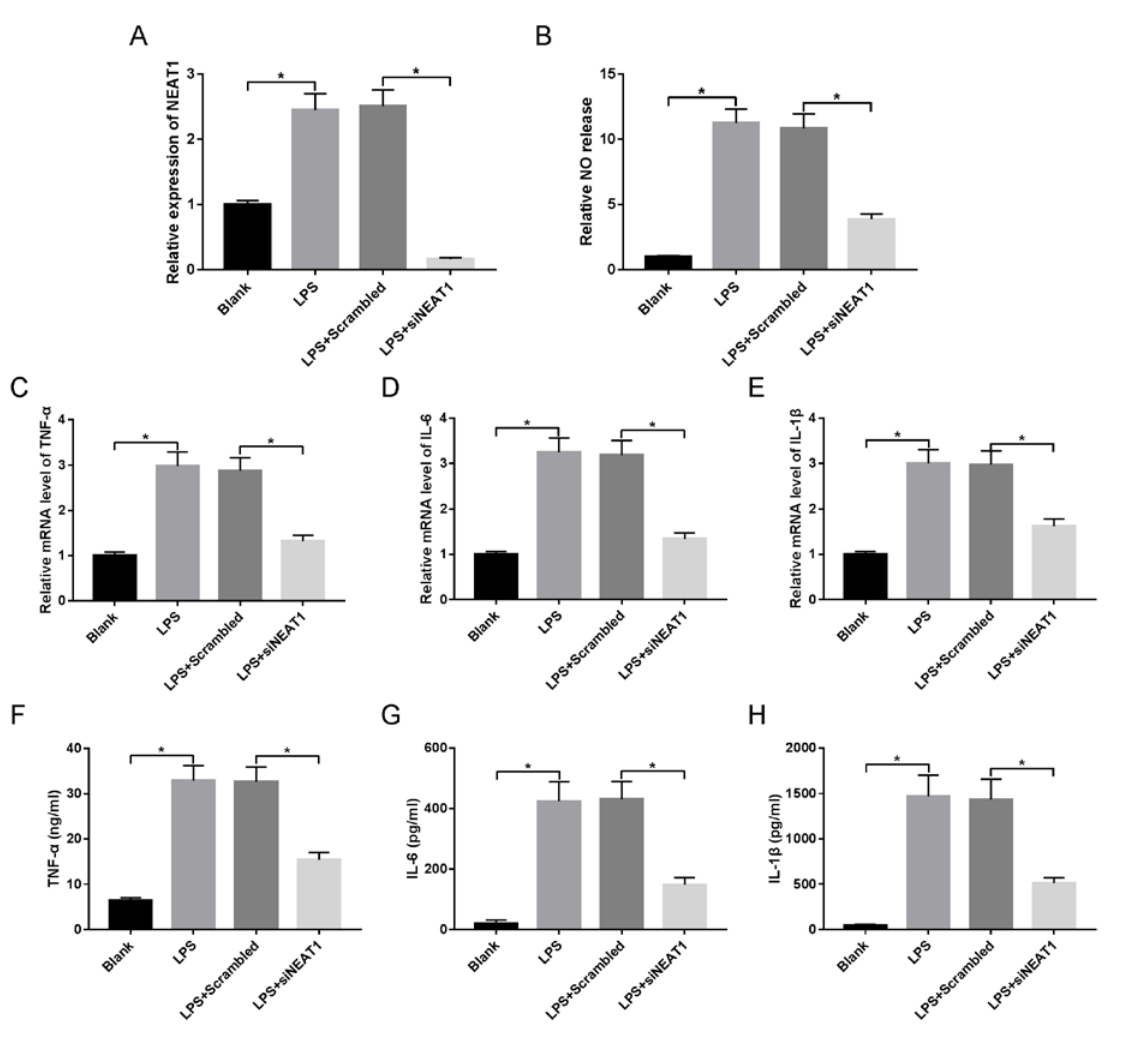
Figure 2: NEAT1 silence inhibits LPS-induced inflammatory injury in macrophages. Macrophages were transfected with siNEAT1 or scrambled and then treated with LPS. NEAT1 expression (A), NO release (B), and inflammatory cytokines secretion (C-H) in each group were measured by qRT-PCR, NO kit or ELISA kit.